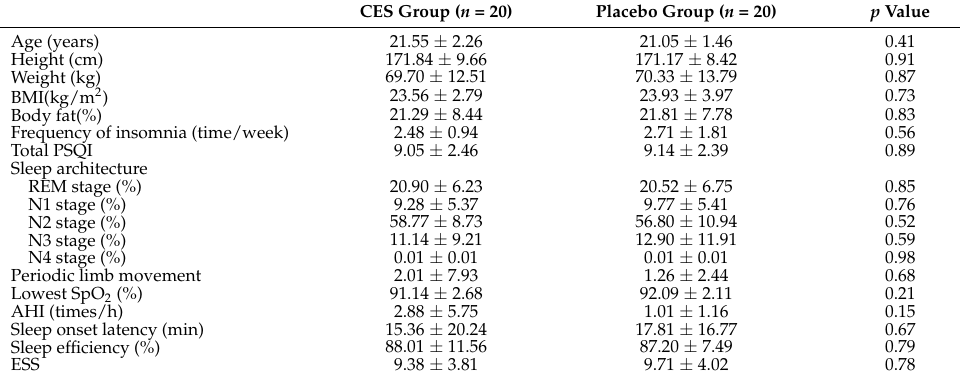
Table 1. Demographic and baseline data of the participants.